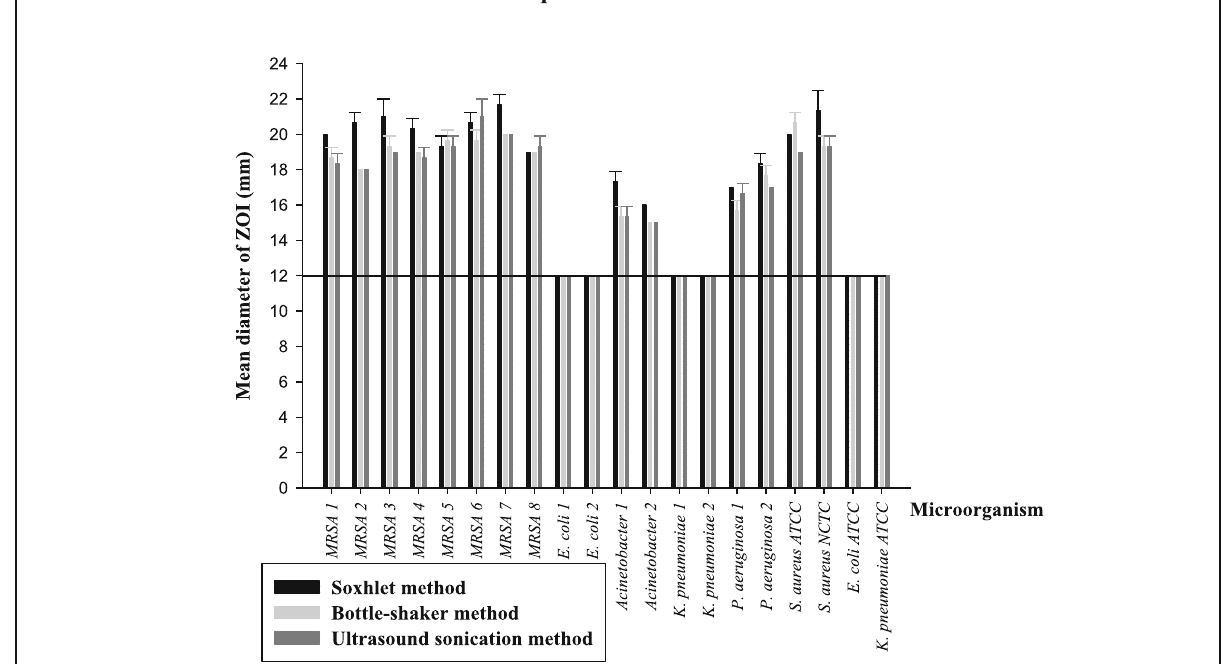
Fig. 3 Mean diameter of zones of inhibition (ZOI) for sequential methanol extracts (10 mg/mL) of Terminalia bellirica prepared from Soxhlet method, bottle-shaker method and ultrasound sonication